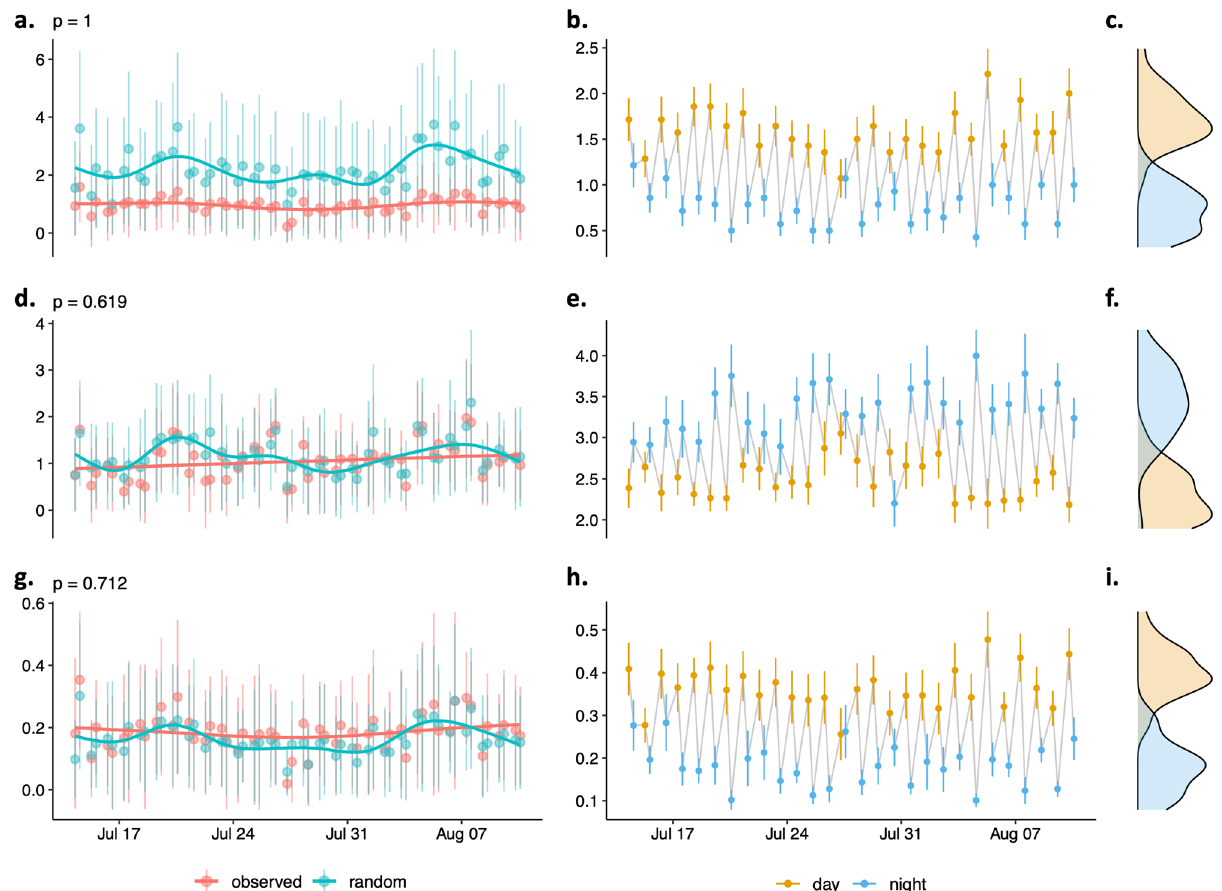
Fig. 4 Non-random patterns in variations of network traits between consecutive days and nights. Observed and random absolute daily differences in network traits between consecutive days and nights in ( a ) individual degree centrality, ( d ) group social differentiation, and ( g ) network density. Permutation-based p values determine whether the observed absolute differences between consecutive daytime and nighttime network traits were larger than random differences predicted under the null hypothesis. Average network trait per day and per night and cumulative distributions of daytime and nighttime average network traits in ( b , c ) individual degree centrality, ( e , f ) group social differentiation, and ( h , i ) network density. Data points represent daily averages and error bars represent the standard deviation around the